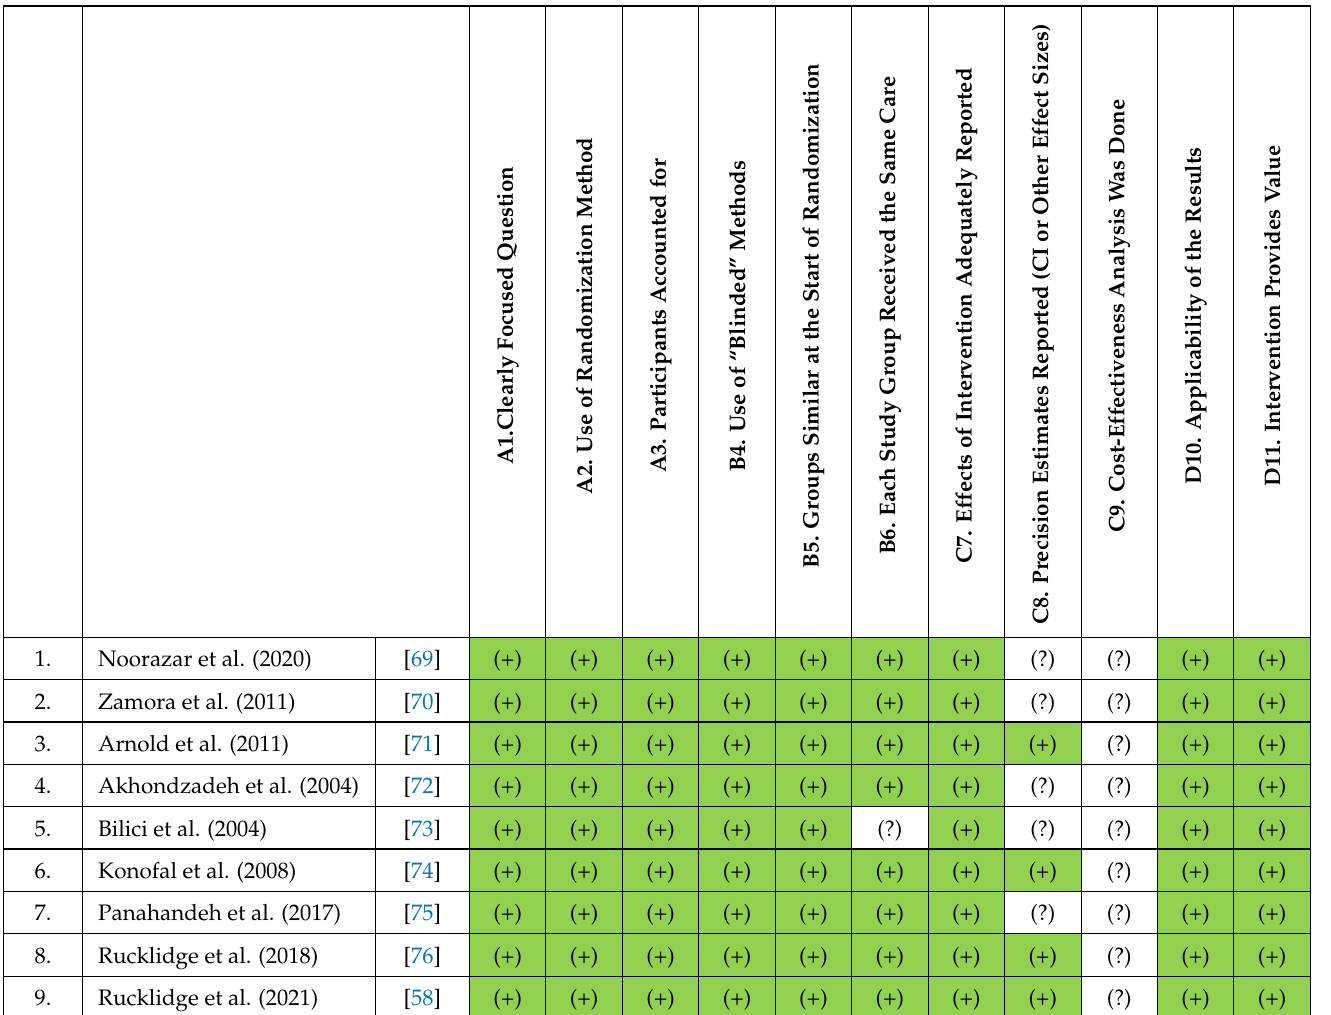
Table 4. Assessment of the studies’ quality based on the CASP